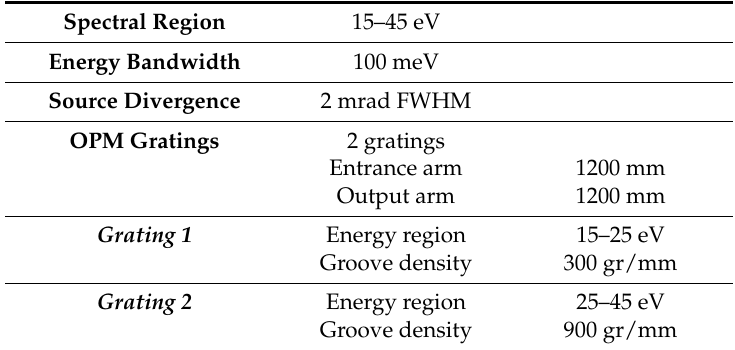
Table 2. Parameters of a CDM monochromator with a target energy bandwidth of 100 meV in the 15–45 eV